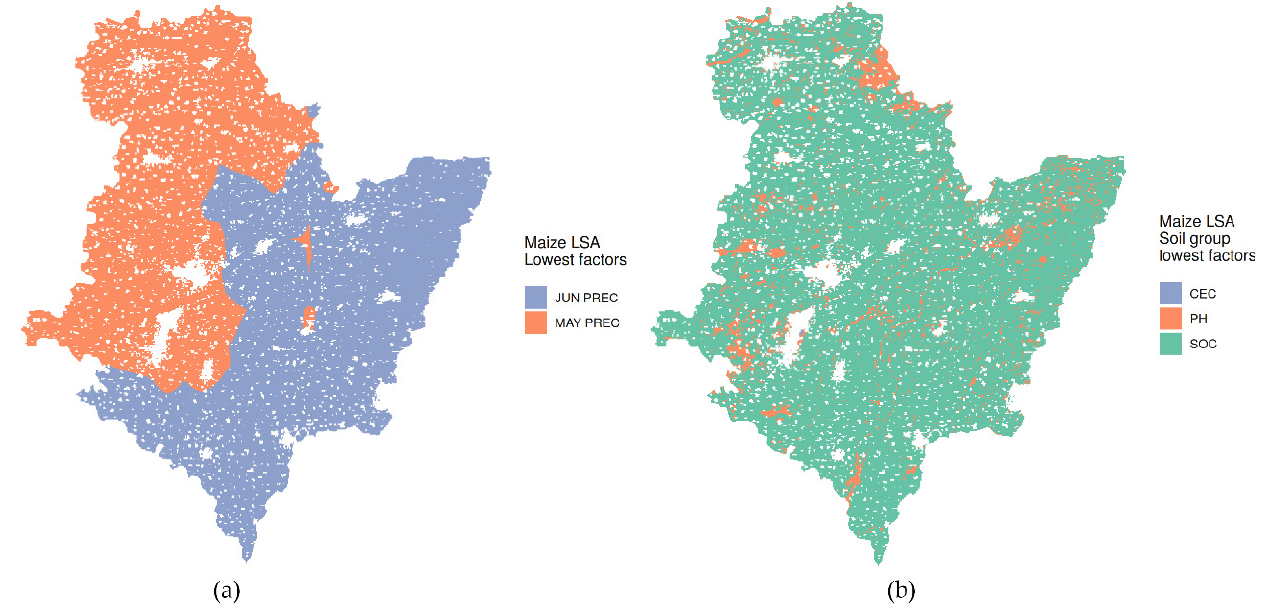
Figure 13. Input parameters with the lowest score for maize in Hengshui ( a ), considering only the soil group ( b ).